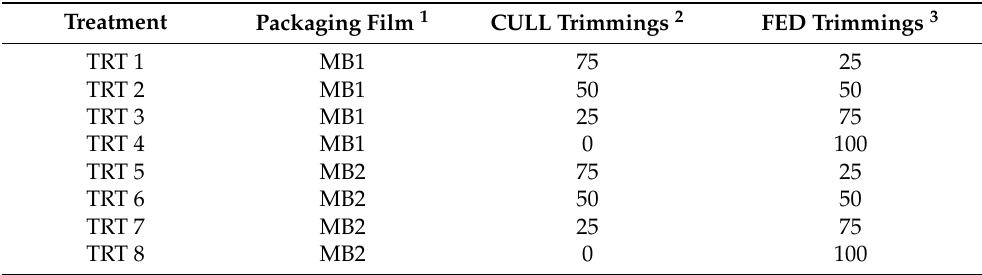
Table 1. Assignment of treatment identifier with beef trimmings and packaging films.